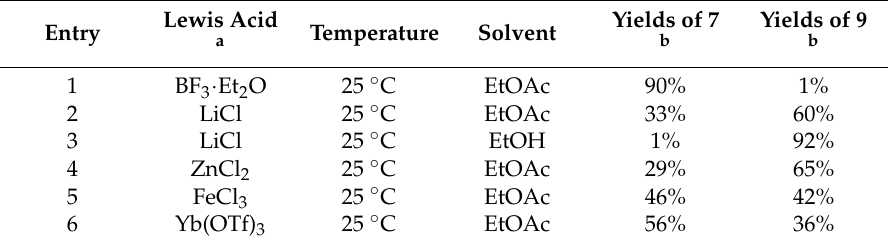
Table 1 . Screening of the reaction conditions. Table 1. Screening of the reaction